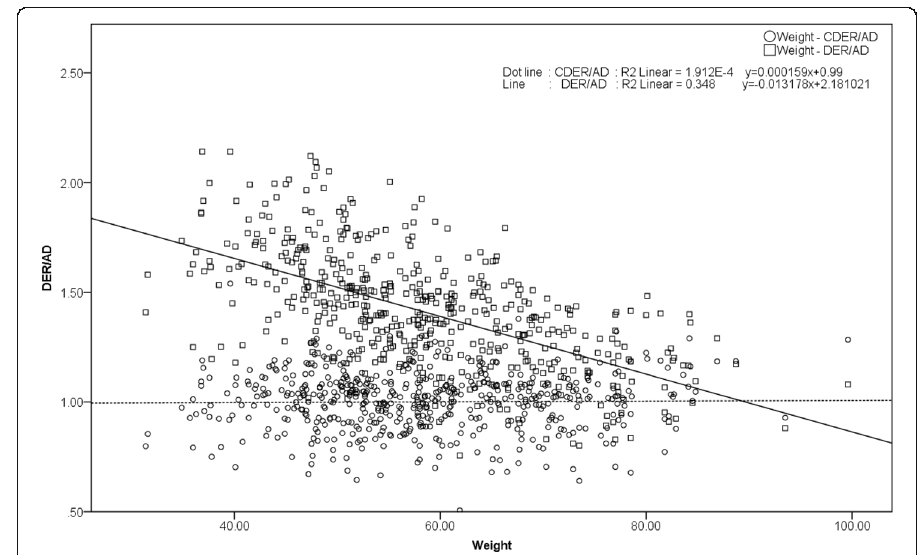
Fig. 1 Scatter plot representing DER/AD. DER dose equivalent rate/administered dosage, AD administered dosage, CDER corrected